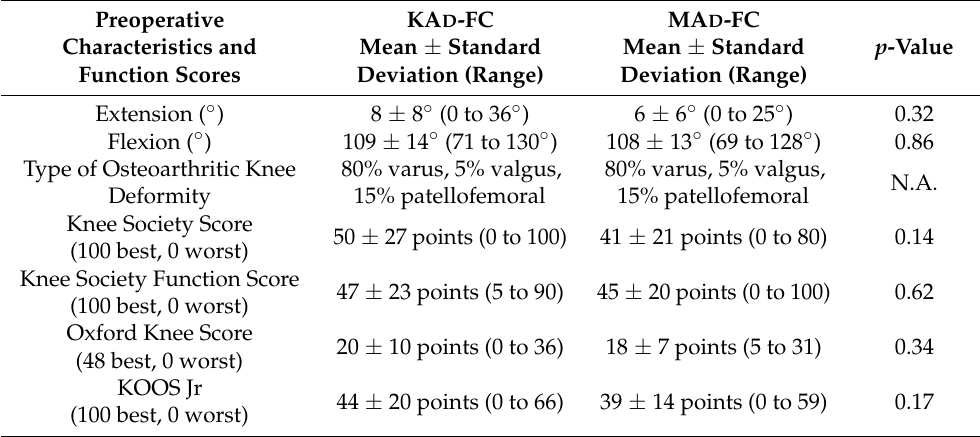
Table 1. Pre-operative knee characteristics, and function scores for the knee treated with the KA D - and MA D -FC for the 35 patients analyzed in the present